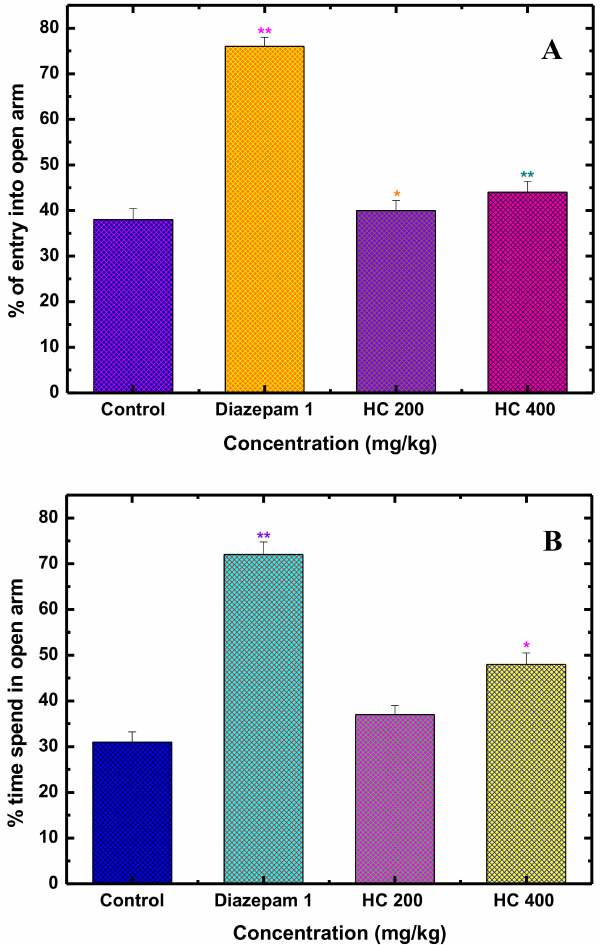
Figure 1. Anxiolytic activity of methanol extract of H. caustica (MEHC) and diazepam on elevated plus maze test in mice. % of entry into open arm ( A ), % time spends in open arm ( B ). Values are mean ± S.E.M. (* p < 0.05) and (** p < 0.01), significantly different from control; ANOVA followed by Dunnett’s test ( n = 6, per group). MEHC: methanol extract of Holigarna caustica ; HC 200, methanol extract of H. caustica 200 mg / kg; HC 400, methanol extract of H. caustica 400 mg / kg; Reference drug diazepam 1 mg /